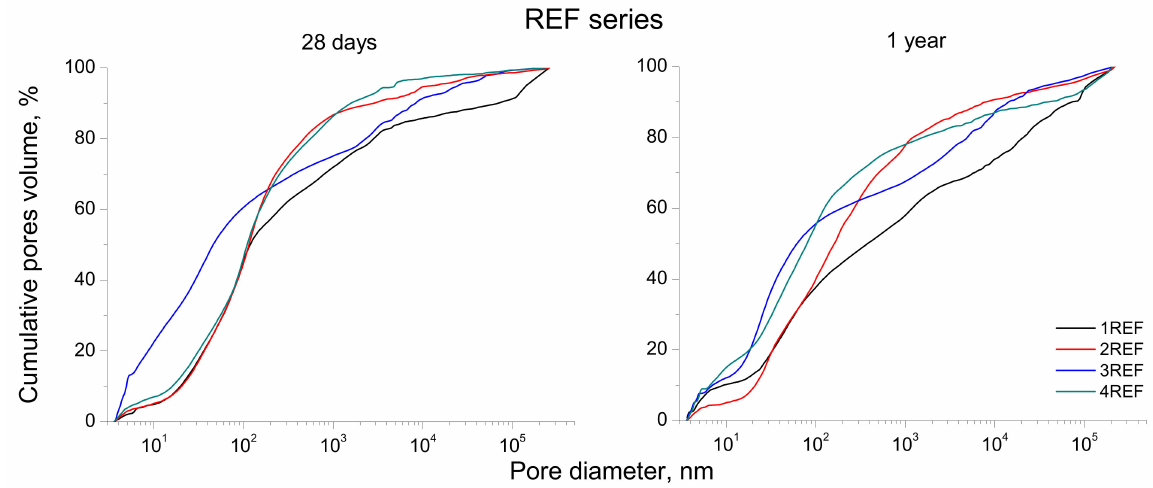
Figure 3. Cumulative volume of pores in percentage versus pore size curves for reference